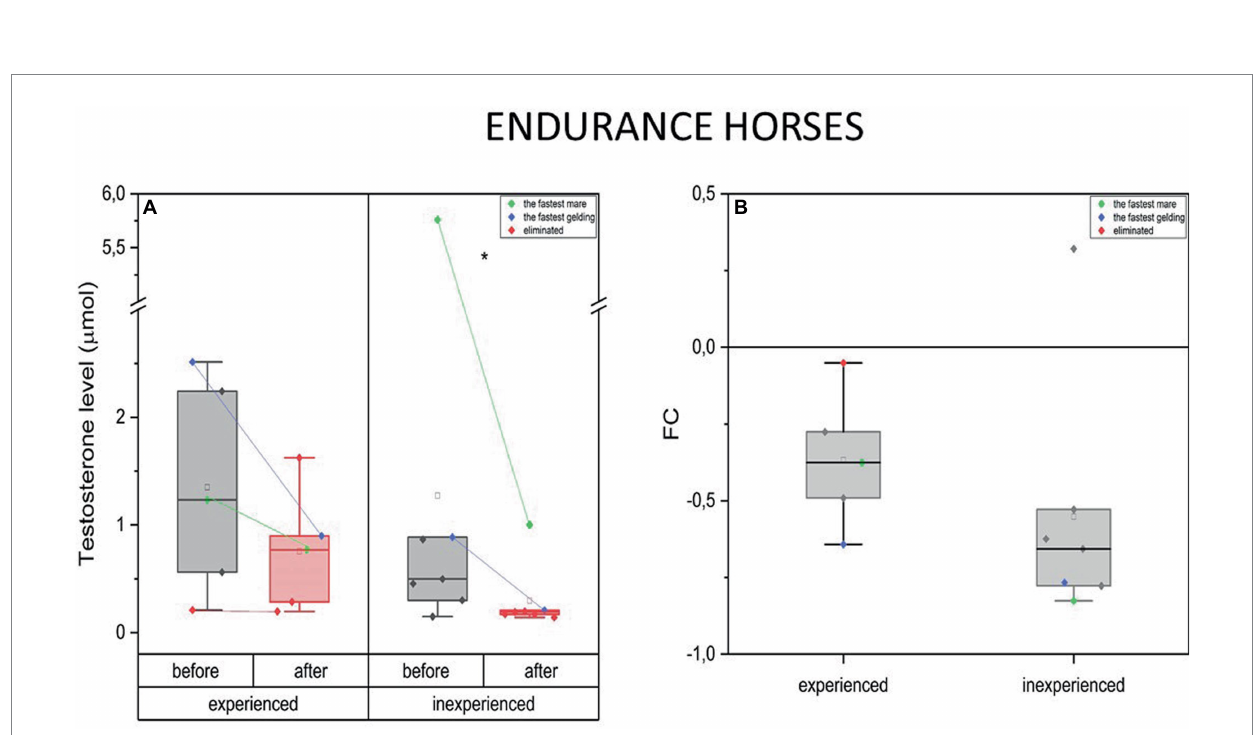
FIGURE 2 Changes in testosterone plasma level upon training in experienced ( n = 5) and inexperienced ( n = 7) endurance horses. Colored data points indicate the fastest mare (green), the fastest gelding (blue), and the eliminated gelding (red). Box plots (IQR, mean and median; whisker range within 1,5 IQR) expressed as differences in molar plasma concentration (A) and fold change (FC) (B) . Statistically significant differences are indicated by asterisks at p < 0.05